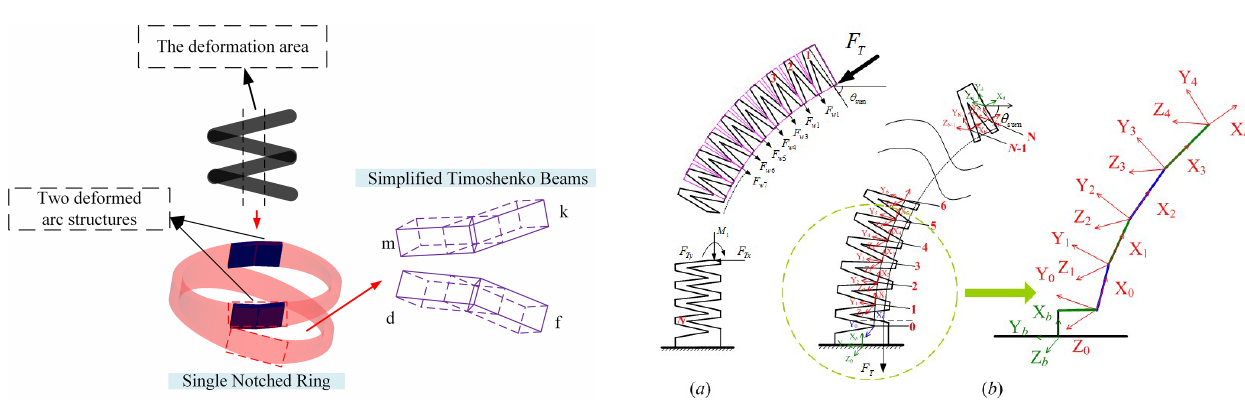
Figure 2. Simplified Timoshenko beams model of a SNR. Figure 3. Equivalent kinematics coordination system of the notched continuum